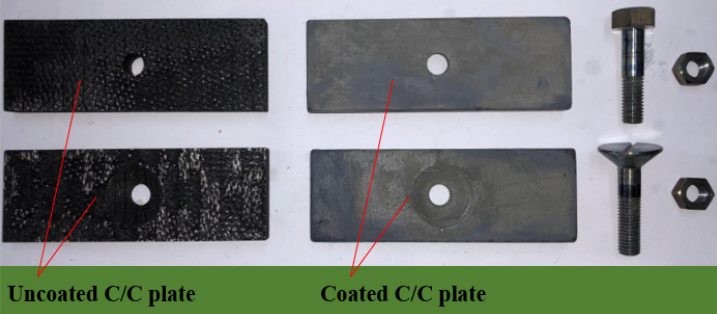
Figure 4. Preparation of the coated C/C composite plates.